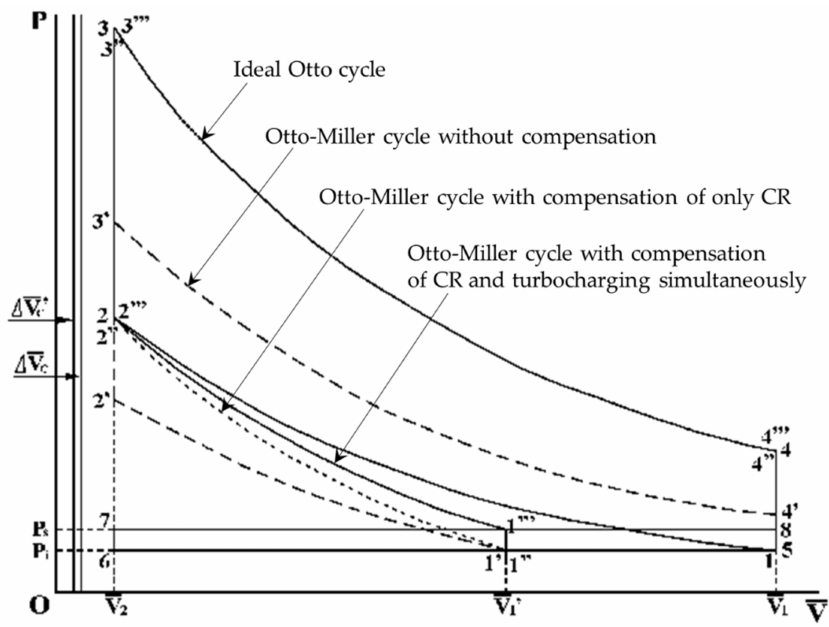
Figure 5. P–V curves showing compensation of only compression ratio (CR) and simultaneous turbocharging in Otto–Miller